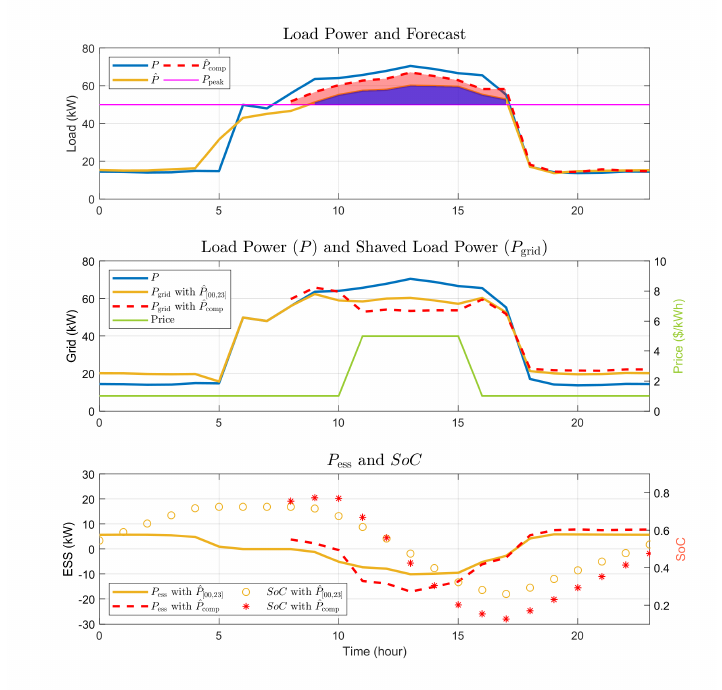
Figure 14. ESS scheduling results. The first figure shows real load power P , load forecast ˆ P by LSTM, and the compensated load forecast ˆ P . The second figure depicts the load power P without ESS comp (blue line), load power P with ESS and ˆ P by LSTM (orange line), and load power P with ESS and ˆ P (red dashed line). In the second figure, the difference between the blue line and red dashed line comp denotes the shaved load power during on-peak time. The green line denotes the time-varying electricity price. The best peak shaving is obtained with ˆ P in the ESS scheduling. The third figure shows comp P and SoC ( t ) ess